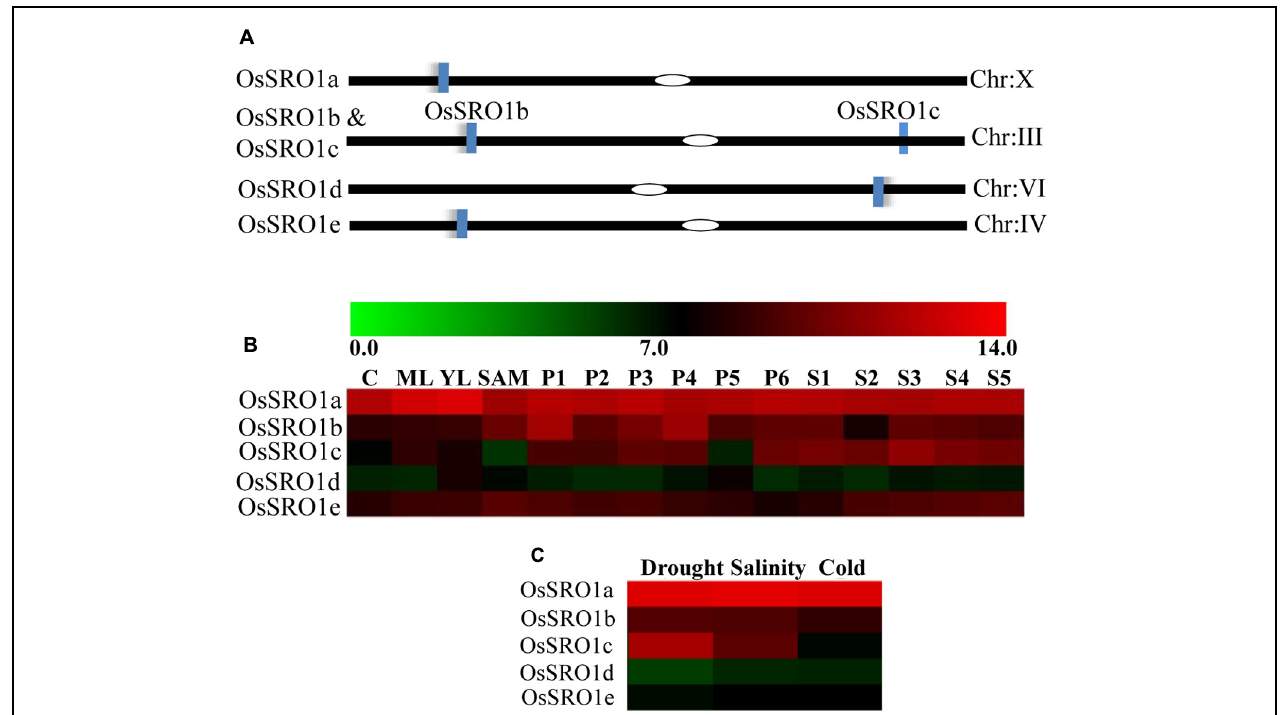
FIGURE 1 | Rice SRO1 genes and their genomic distribution on chromosomes. (A) Genomic distribution of OsSRO1 genes on rice chromosomes. Chromosome number is indicated at the right and blue bars represent position of the OsSRO1 genes. (B) Expression profile of OsSRO1 genes at different developmental stages as mentioned on top of each column viz. 7 days seedlings taken as control (C), mature leaf (ML), young leaf (YL), shoot apical meristem (SAM), young inflorescence (PI, up to 3 cm), inflorescence (P2, 3–5 cm; P3, 5–10 cm; P4, 10–15 cm; P5, 15–22 cm; P6, 22–30 cm) and seed (S1, 0–2 dap; S2, 3–4 dap; S3, 5–10 dap; S4, 11–20 dap; S5, 21–29 dap), and (C) stress conditions such as drought, salinity, and cold using microarray data. Color bar at the top represents expression values, thereby green color representing lowest expression levels and red signifying highest expression